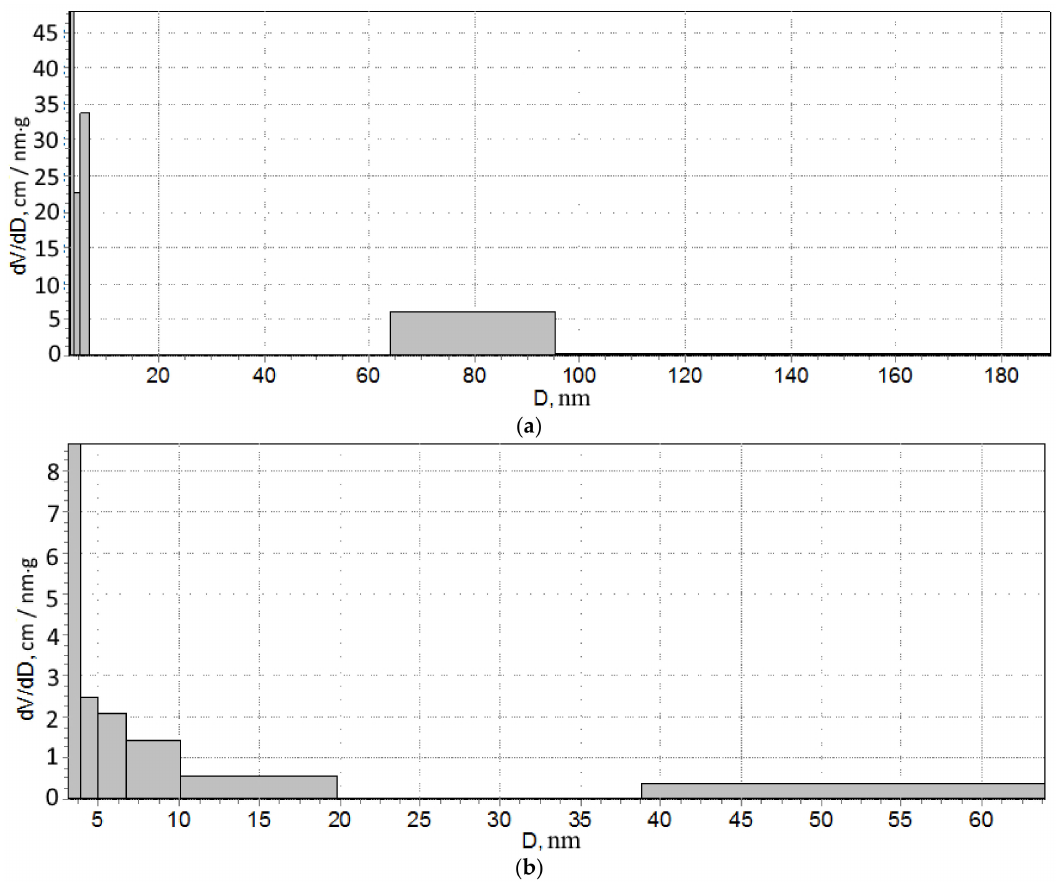
Figure 15. The porosity of the pressed composites depending on the composition: ( a ) control; ( b ) experimental with 15%